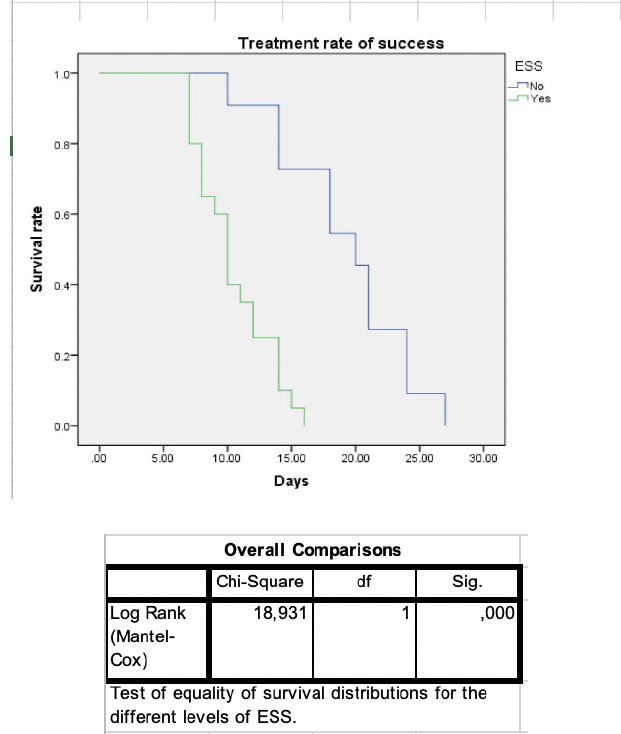
Figure 6. Kaplan–Meier curves representing time to resolution of odontogenic sinusitis between patients undergoing oroantral fistula alone or concomitant endoscopic sinus surgery (ESS). Mean time to healing was 10 days for ESS, and 20 days when ESS was not associated. 1 Log-Rank test for comparing survival rates shows a statistically significant difference ( p = 0.001).